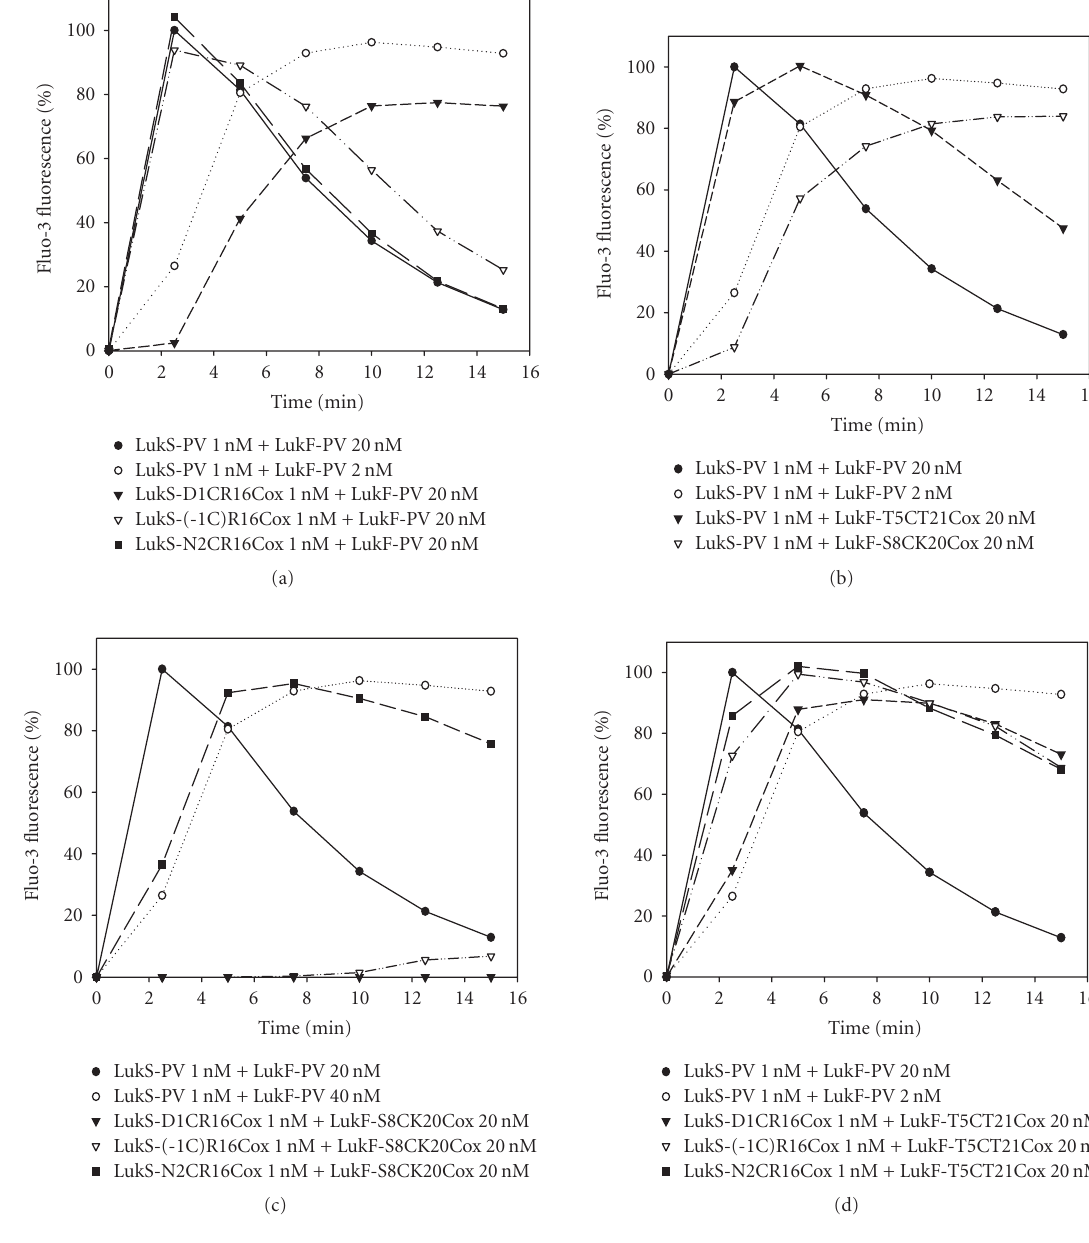
Figure 5: Flow cytometry evaluation of Ca 2+ entry into human PMNs for di ff erent combinations of purified WT S and F proteins and their oxidized double mutants. (a) Oxidized LukS-PV mutants were tested with WT LukF-PV. (b) Oxidized LukF-PV double mutants were tested with WT LukS-PV. (c) Oxidized LukS-PV double mutants were tested with LukF-PV S8C-K20Cox. (d) Oxidized LukS-PV double mutants were tested with LukF-PV